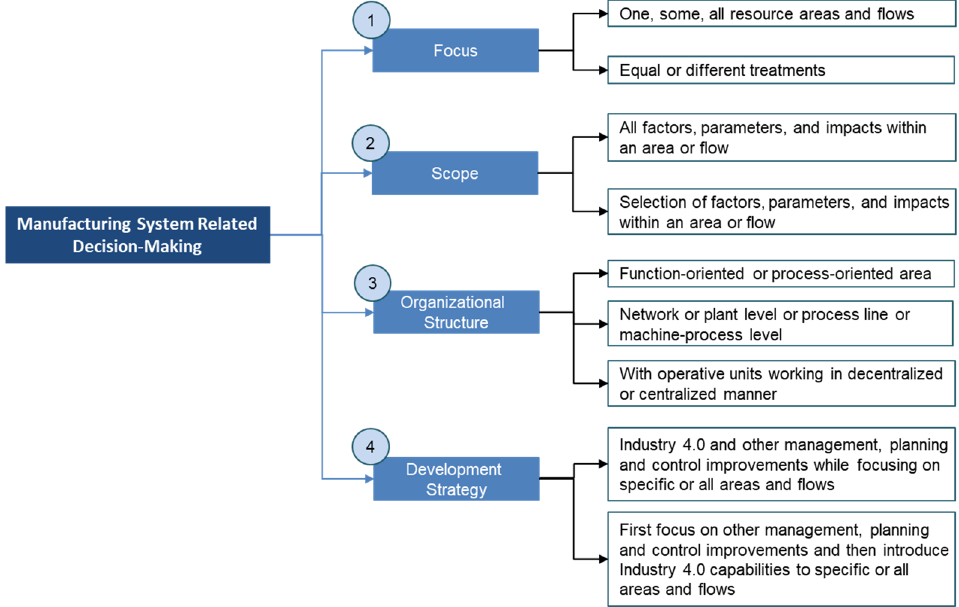
Figure 4 . Manufacturing system and related decision-making options (own elaboration). Figure 4. Manufacturing system and related decision-making options (own